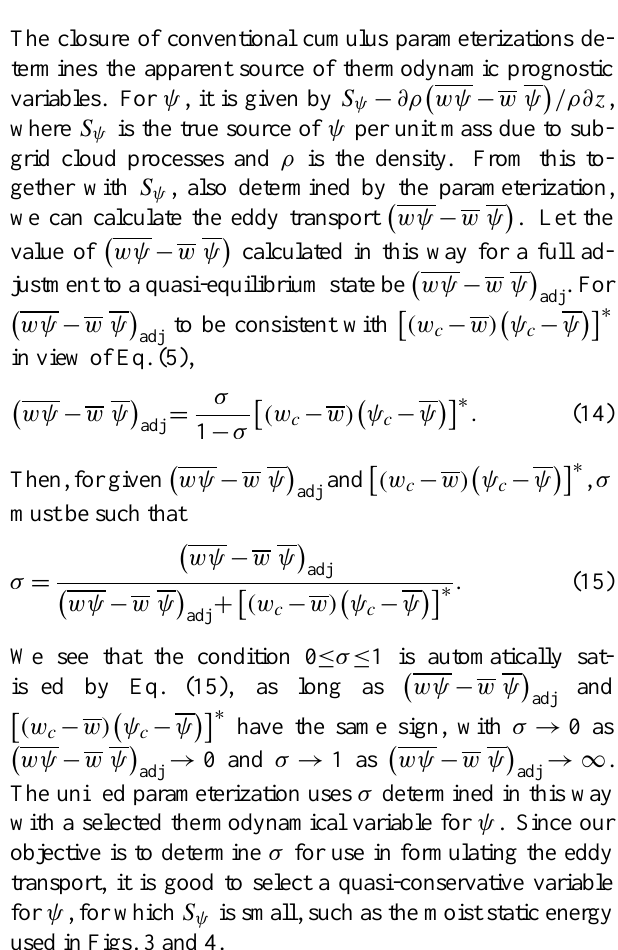
Fig. 9. The σ -dependence of the diagnosed (wq − w q) averaged over all sub-domains that share σ in the same sub-range for the case in bold face in Table 1a. The dashed curve shows σ (1 − σ ) multiplied by a constant chosen for the best fit to the dots for small and medium values of σ .